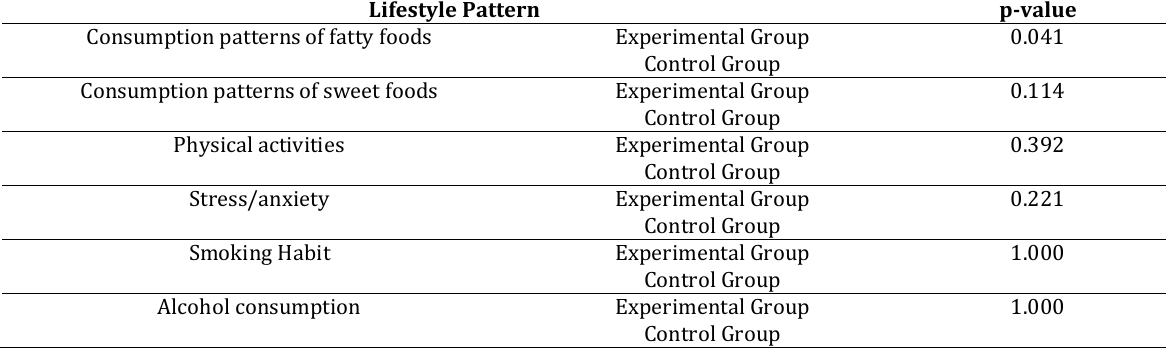
Table 5. Mann Whitney test analysis results - differences in the healthy lifestyle behaviour between the experimental and control